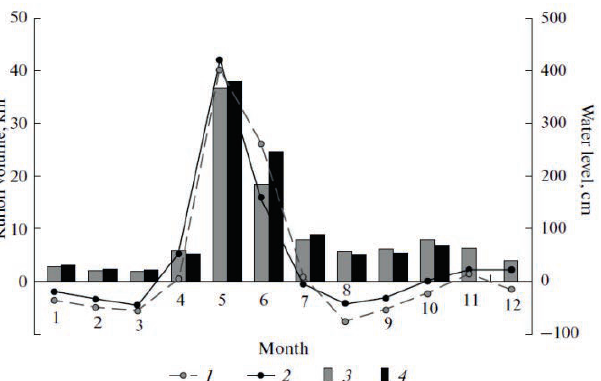
Fig. 2 Annual distribution of the levels and runoff in the mouth area of the Northern Dvina River (at the Ust’-Pinega hydrological station) (Kravchishina et al. 2010), courtesy Pleiades Publishing, Inc. 1 : level, long-term average data; 2 : level in 2004; 3 : runoff volume 1881–1980; 4 : runoff volume,